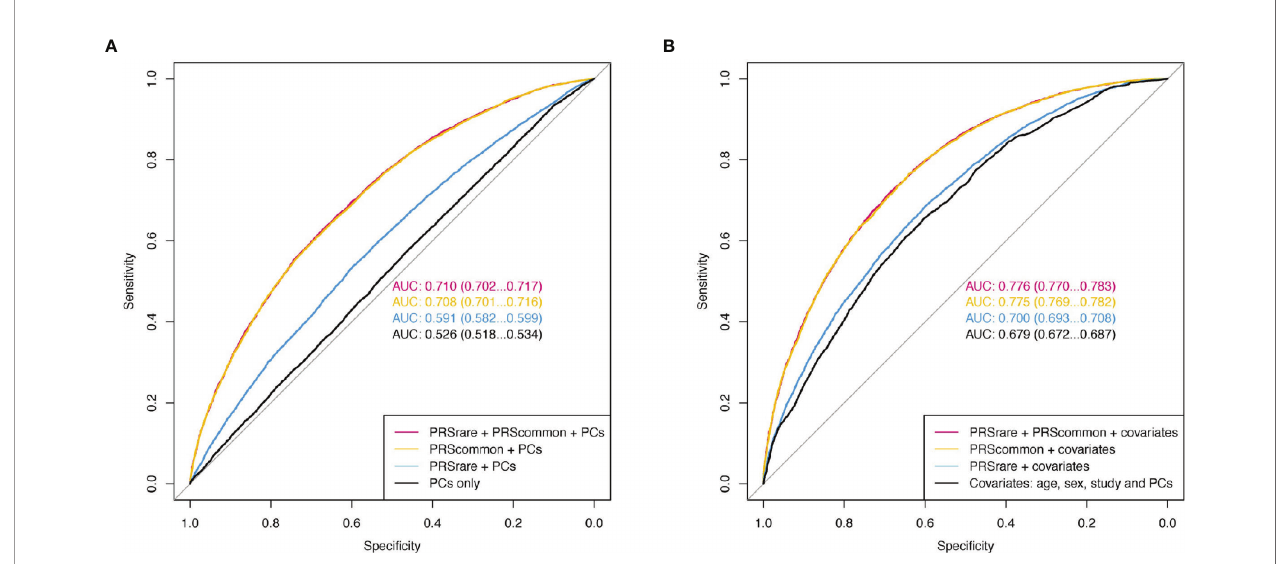
FIGURE 5 | The receiver operating characteristic curve (ROC) of obesity. (A) Model only included PCs as baseline covariates. (B) Additionally included age, sex, and study. PRSrare includes PRS rare-lassosum and PRS rare-burden